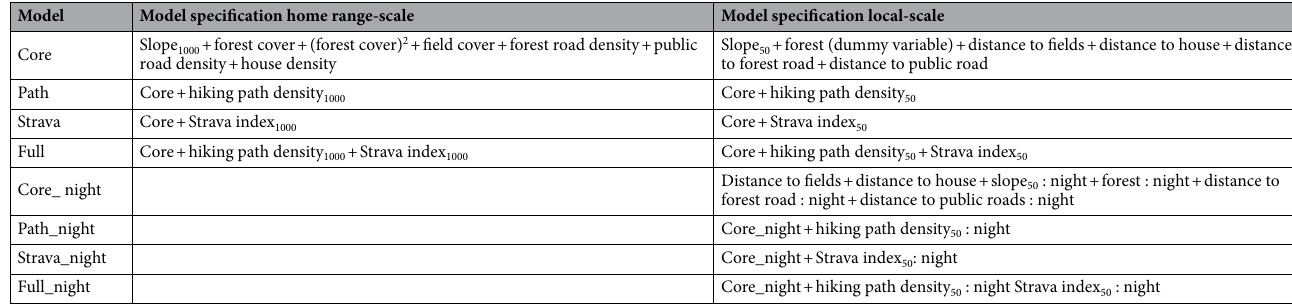
Table 1. Candidate models for home range-scale and local-scale habitat selection Refer to Table S2 and S3 to see how the covariates were prepared for the different scales. The night interaction was only considered at the